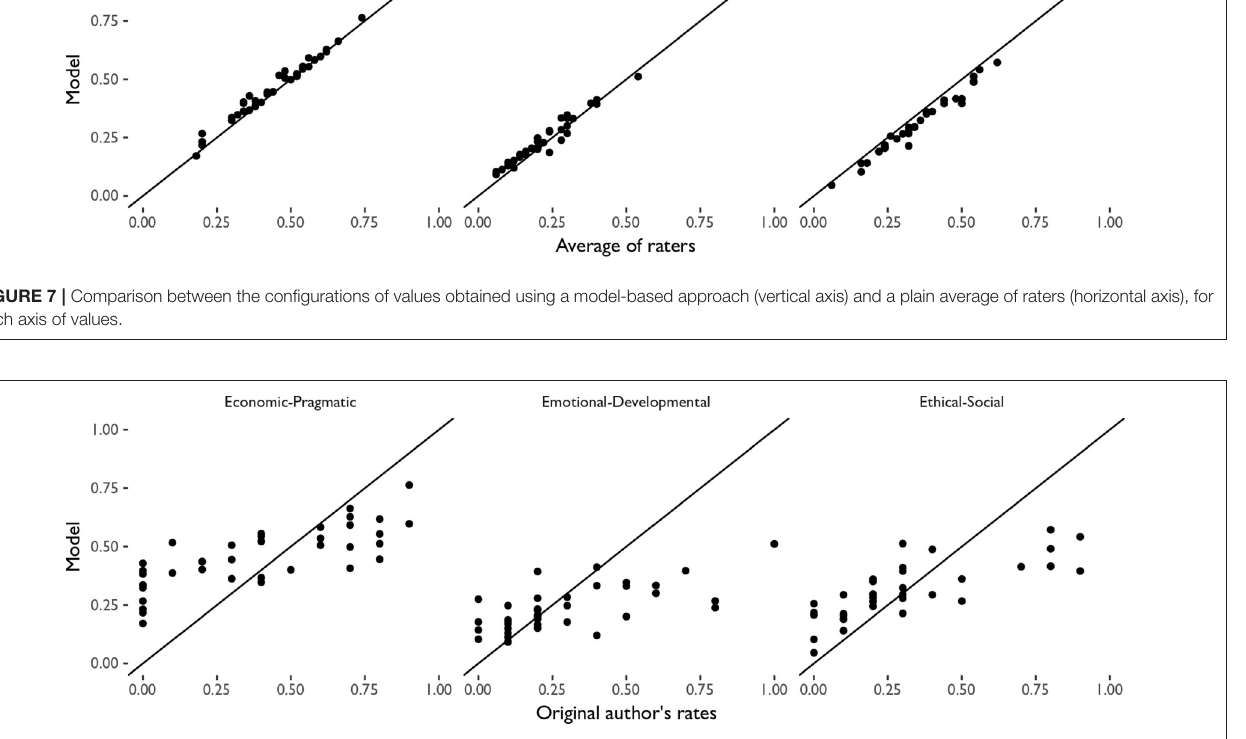
FIGURE 8 | Comparison between the configurations of values obtained using a model-based approach (vertical axis) and the original author’s rate (horizontal axis), for each axis of values.